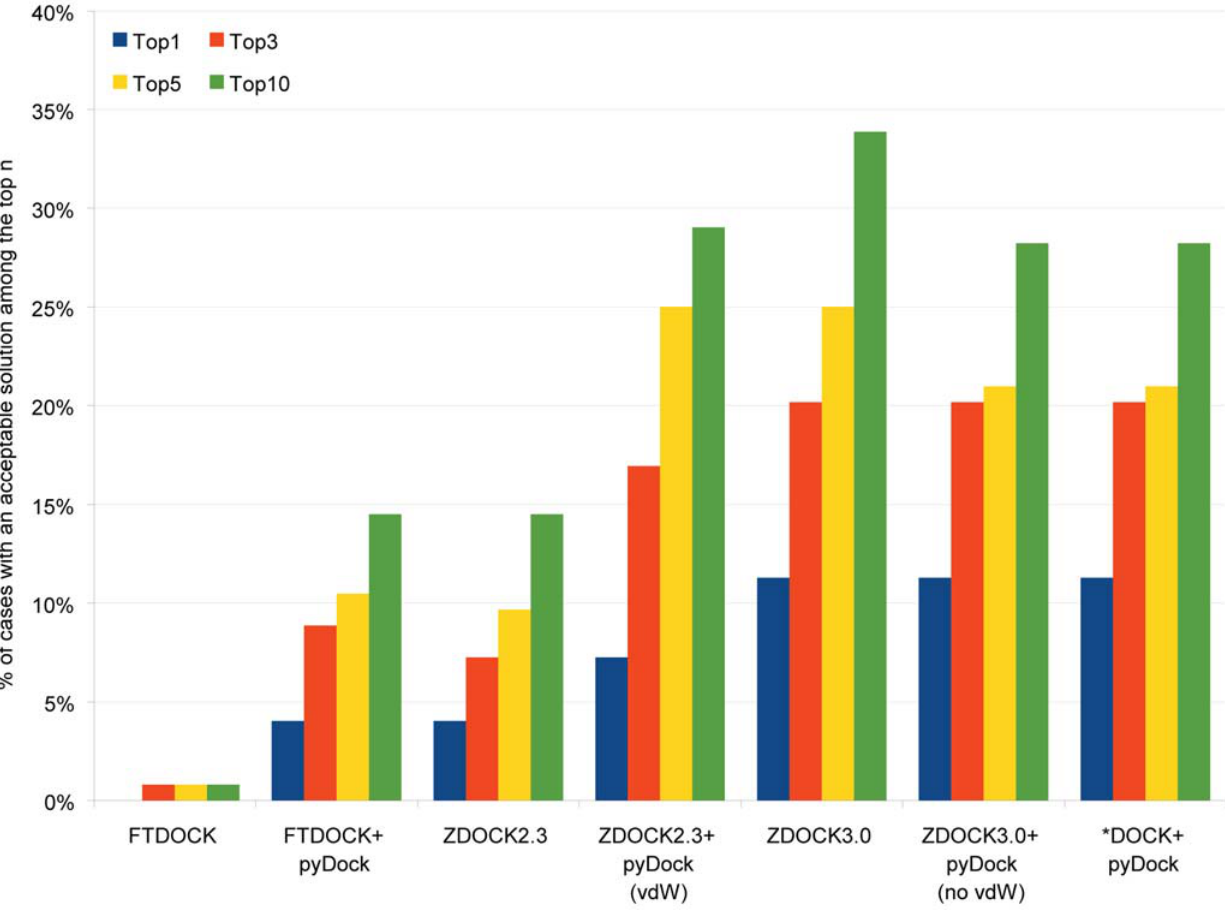
Figure 1. Percentage of cases with an acceptable solution ranked in the top positions. Percentage of cases for which an ‘‘at least acceptable’’ solution is found in the top n (n=1,3,5,10) for the different docking tools that have been tested.